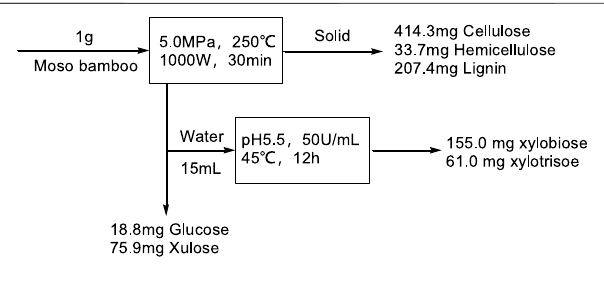
FIGURE 4 | Material balance of MA-LHW pretreatment and acid